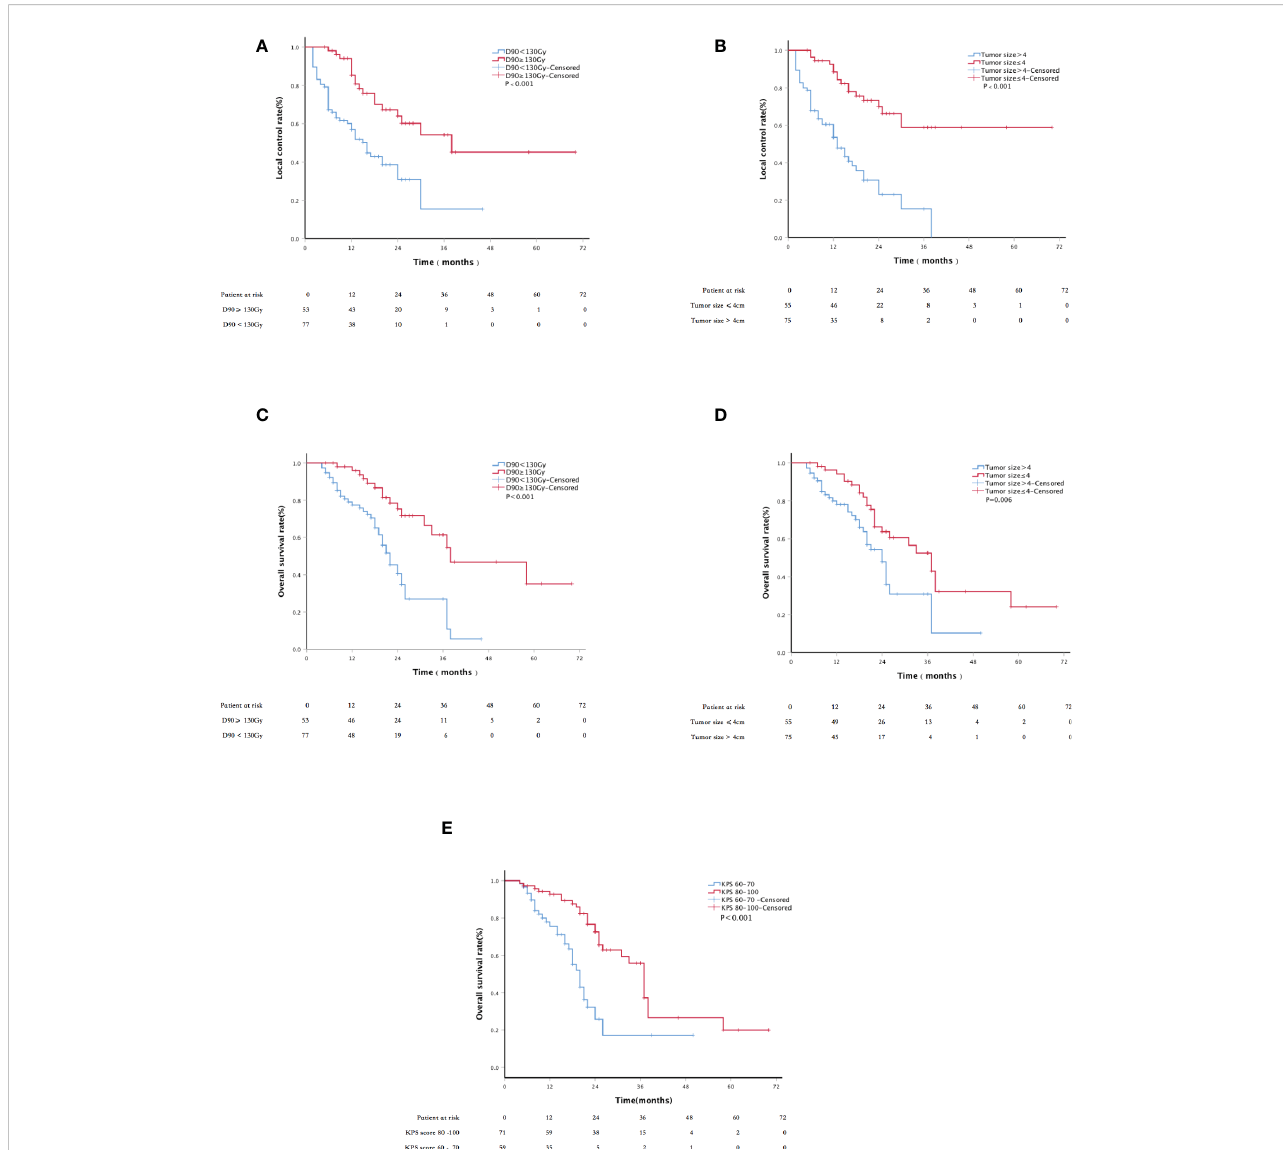
FIGURE 3 Kaplan – Meier curve about LC and survival: (A) the LC of patients with D90 ≥ 130 Gy and D90 < 130 Gy; (B) the LC of tumor size ≤ 4 cm and tumor size >4 cm; (C) the overall survival (OS) of patients with D90 ≥ 130 Gy and D90 < 130 Gy; (D) the OS of patients with tumor size ≤ 4 cm and tumor size >4 cm; and (E) the OS of patients with KPS scores 60 – 70 and 80 –